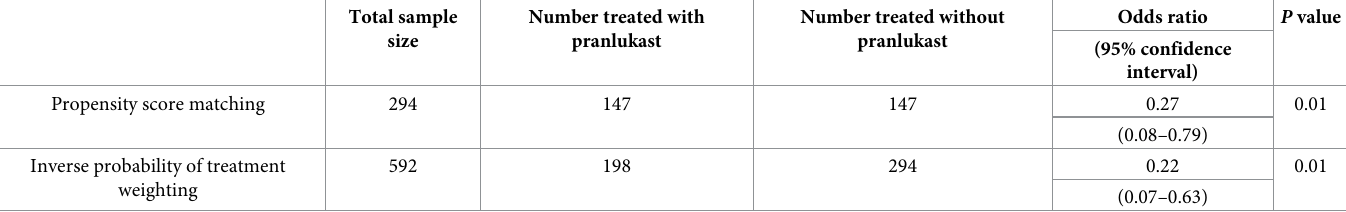
Table 4. Relative likelihood of requiring respiratory support among infants treated with pranlukast according to the propensity score-matched analysis and the inverse probability of treatment-weighted analysis. Total sample